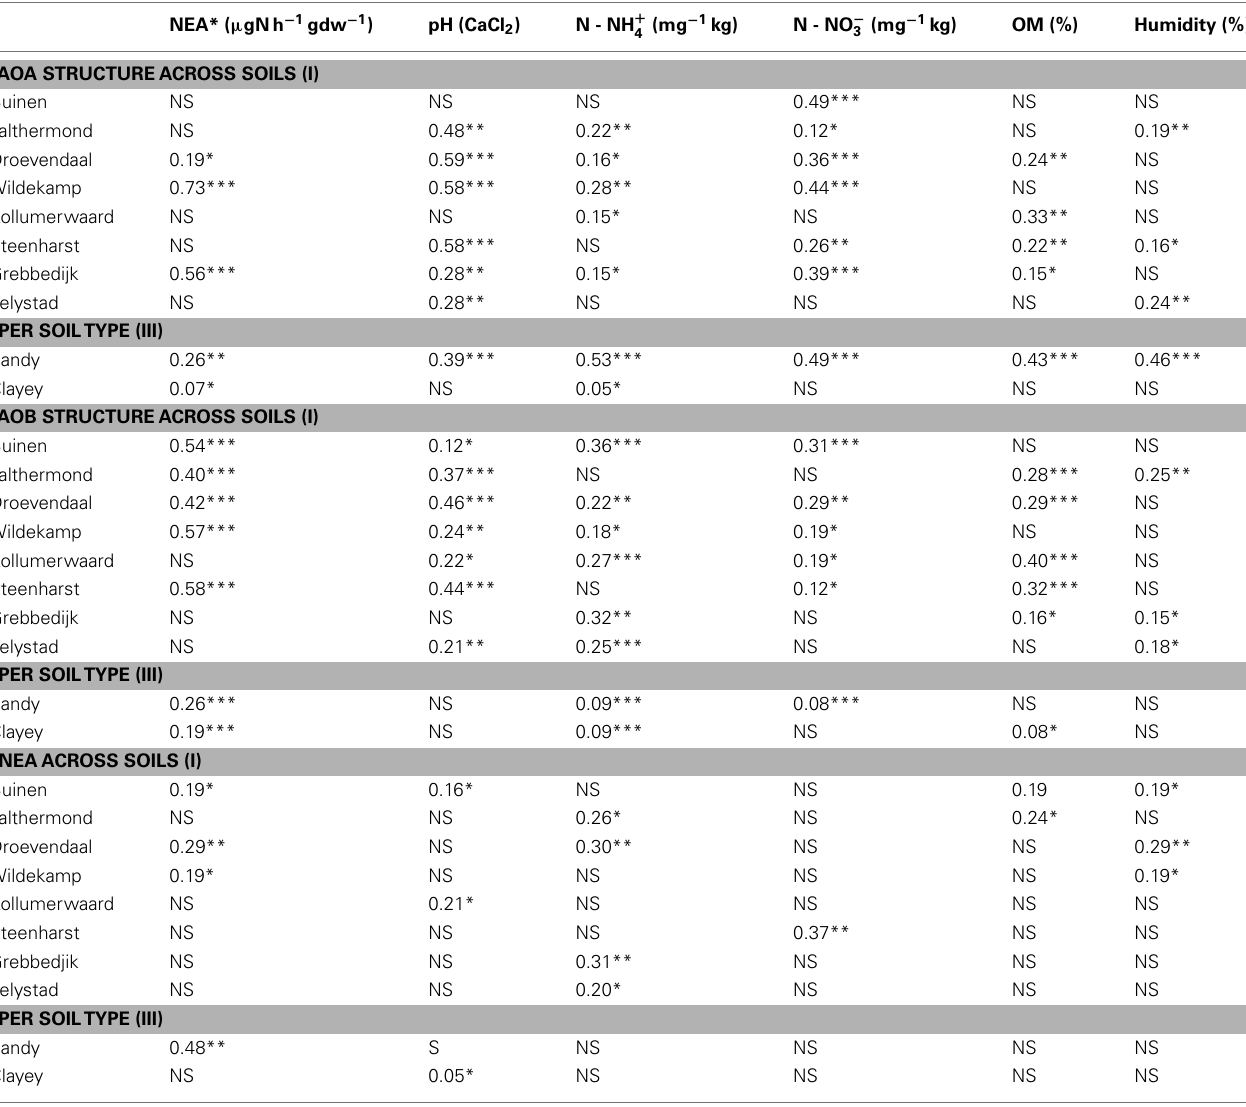
Table 4 | Correlations between the community structureAOA andAOB, soil chemical parameters (pH, N - NH + and water content %) and NEA ( Relate Analysis) obtained with Primer-E (BEST test), for all sampling times per soil and per soil